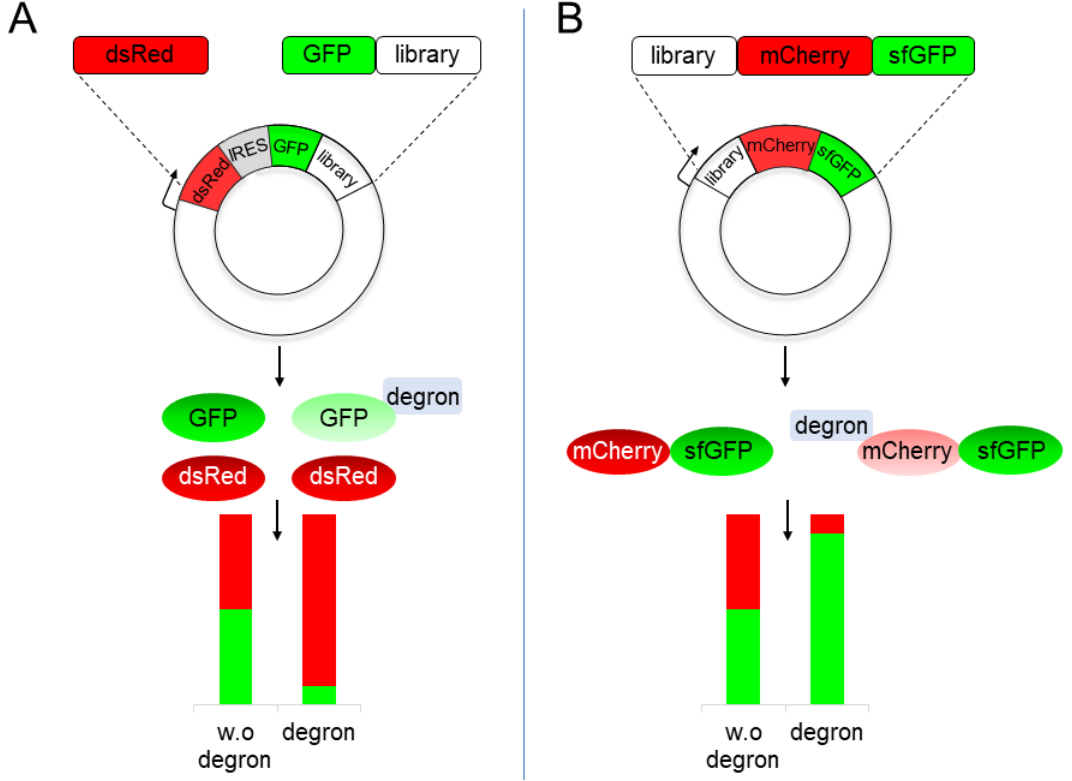
Figure 3. High throughput (HTP) degron screens using a GFP reporter. ( A ) The global protein stability (GPS) cassette consists of an internal ribosome entry site (IRES), flanked by Dicscosoma red fluorescent protein (dsRed) and a GFP-library coding sequences, all of which are transcribed from a single promoter albeit translated separately. Reduced GFP/RFP indicates destabilization of the GFP, due to the presence of a degron. ( B ) Tandem fluorescent timers (tFT) cassette consists of library-mCherry-sfGFP fusion. Reduced mCherry/sfGFP ratio is attributed to the presence of a degron that shorten the half-life of the chimera protein. mCherry: monomeric Cherry; sfGFP: super folder GFP; w.o: without.